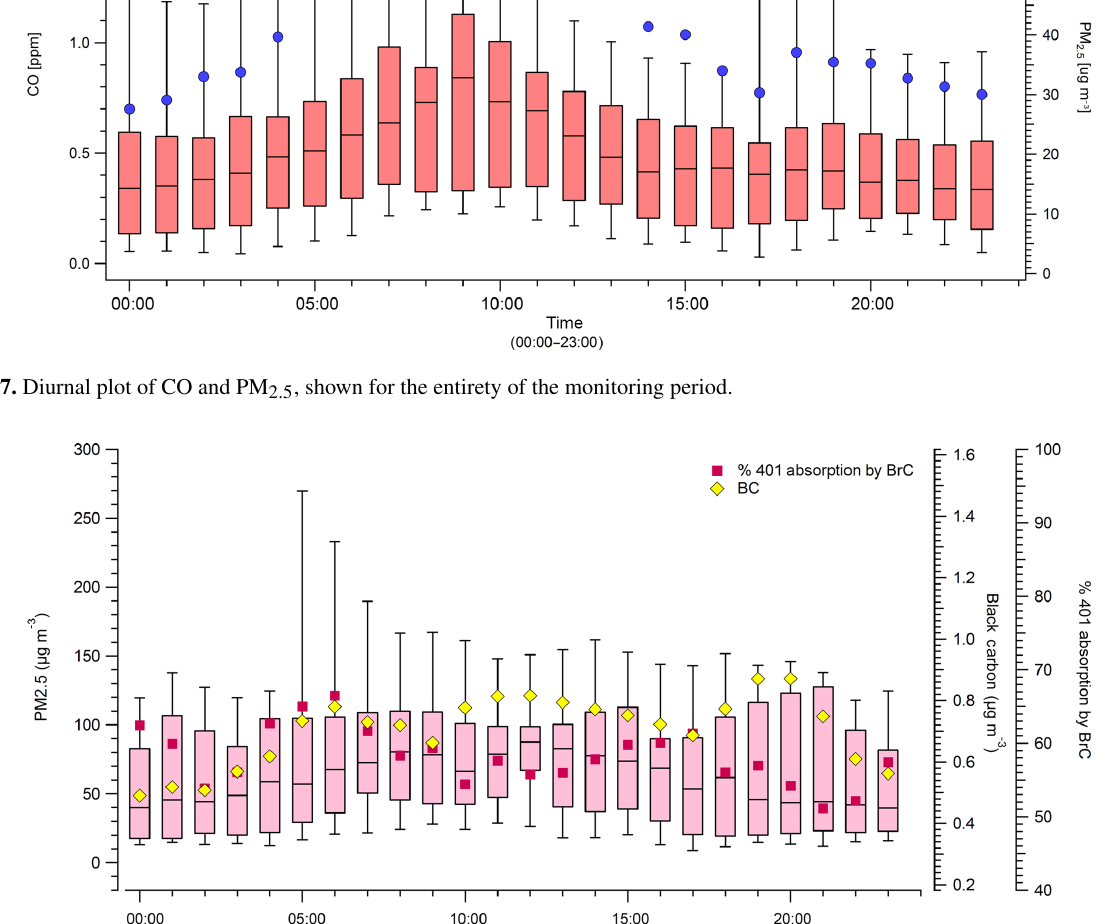
average for the entire sampling period of ∼ 54 µg m − 3